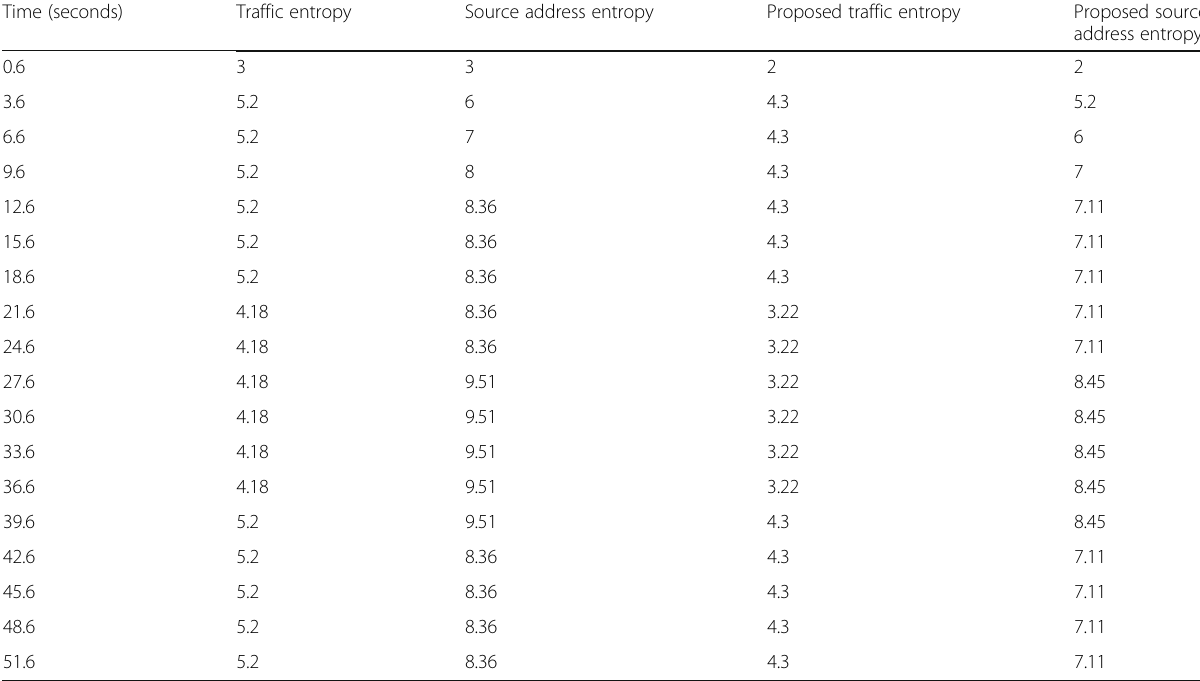
Table 5 Entropy during normal web traffic with spoofed DDoS. During DDoS attacks, source address entropy and traffic entropy are observed at different times